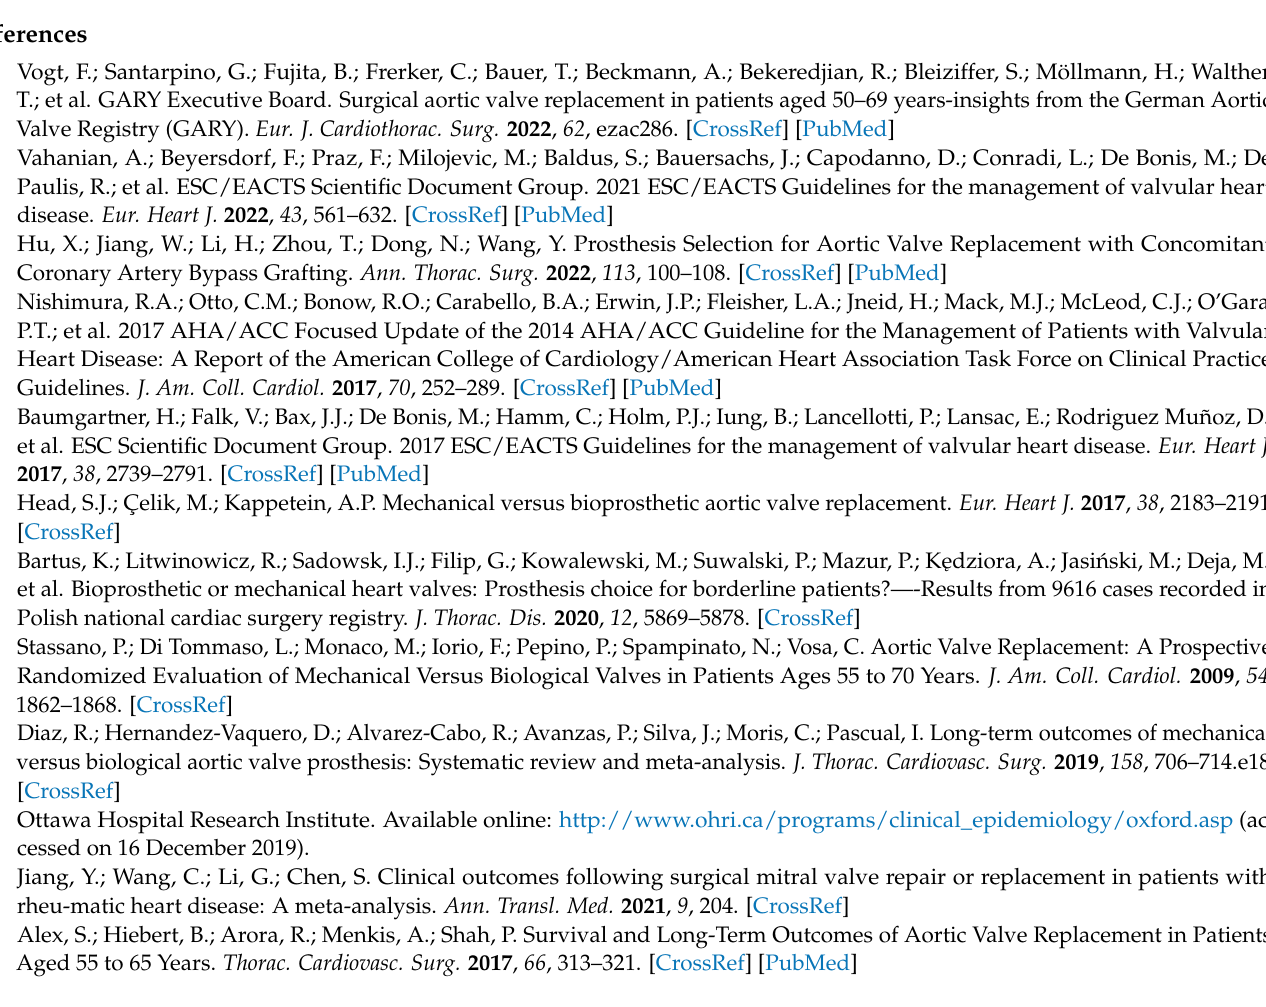
stroke. Figure S2: Subgroup analysis of patients aged from 50 to 65-years-old (RCT or PSM). (A) Early mortality. (B) Long-term survival. (C) Freedom from reoperation. (D) Freedom from valve-related events. (E) Freedom from bleeding. (F) Freedom from